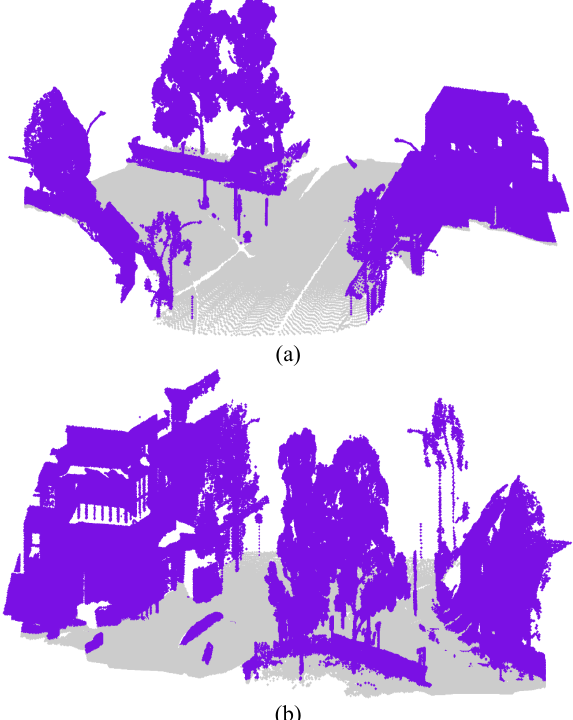
Table 1. Results from RLWR and segmentation algorithms Data Set